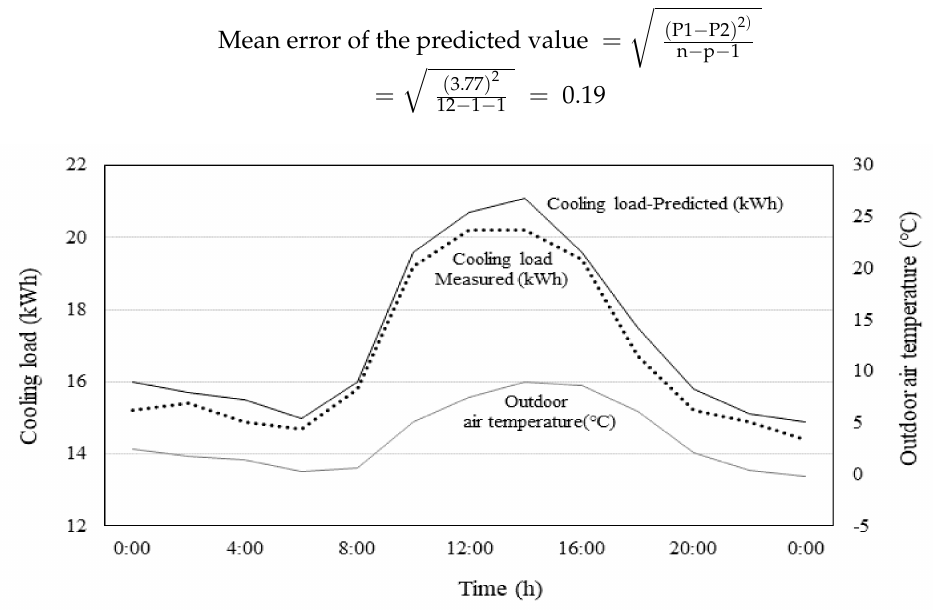
Figure 5. Predicted result of the daily cooling load compared with the measured one for a typical